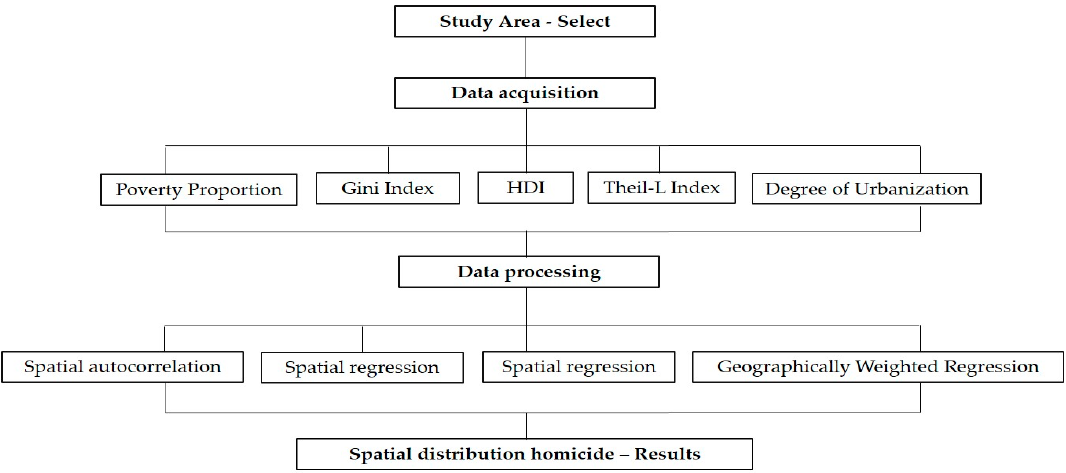
Figure 3. Synthesis of the methodological procedure.